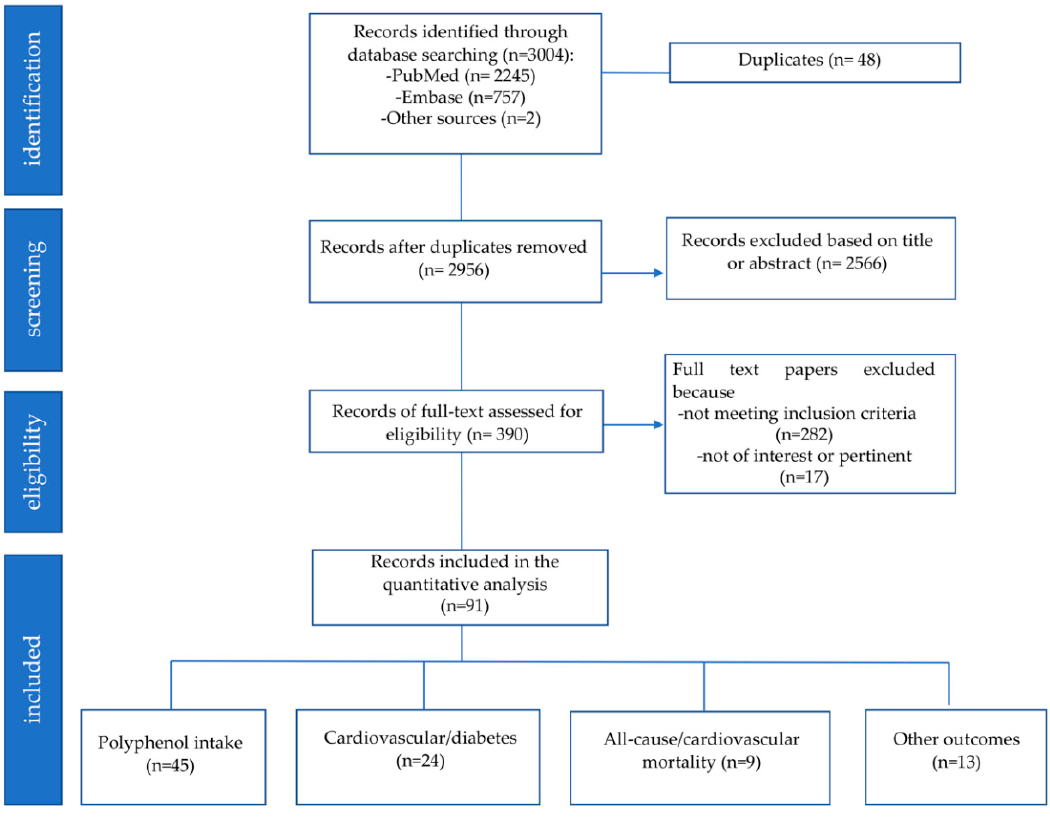
Figure 2. PRISMA Diagram